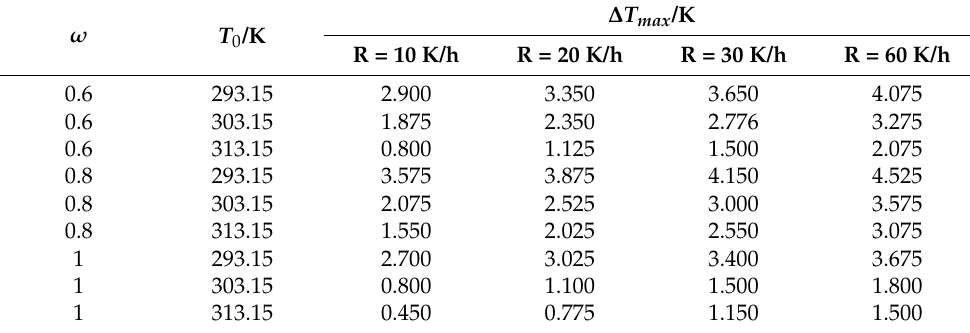
Table 2. Metastable zone of PMBA in different ethanol mass